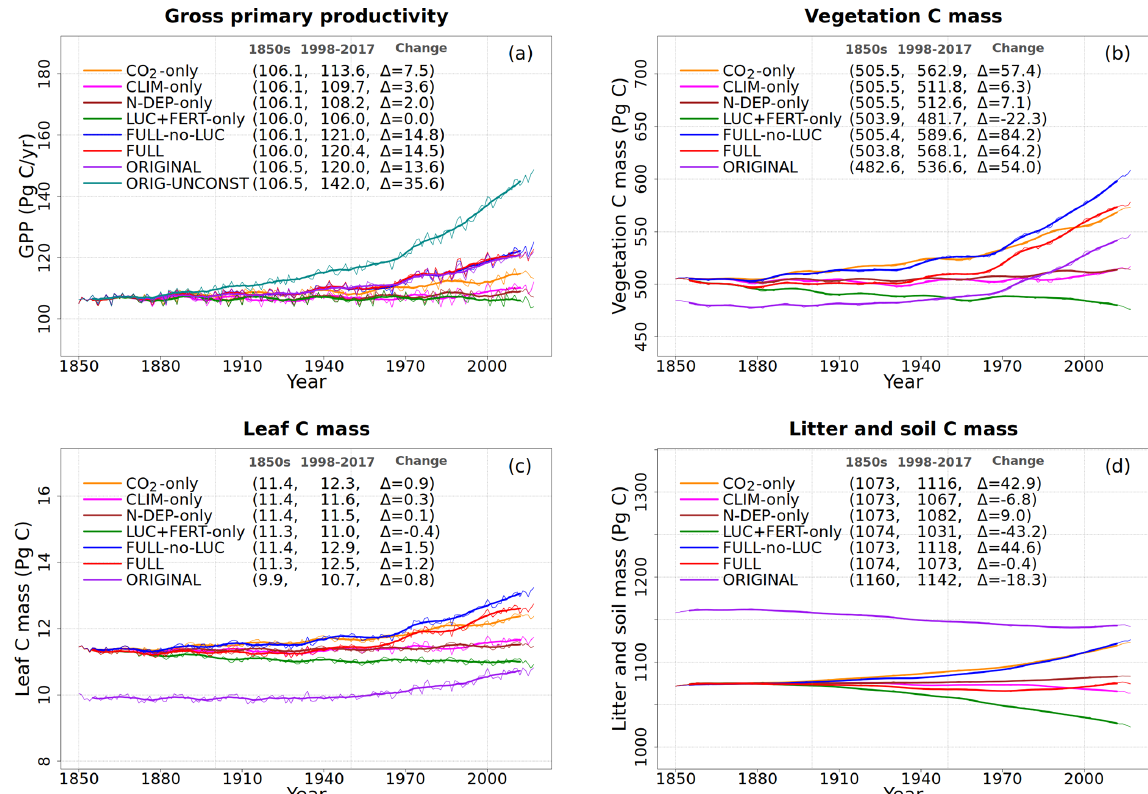
Figure 4. Global annual values of gross primary productivity (a) , vegetation carbon (b) , leaf carbon (c) , and litter and soil carbon (d) for the primary simulations performed. The values in the parentheses for legend entries show the average for the 1850s, the average for the 1998–2017 period, and the change between them. The thin lines show the annual values, and the thick lines show their 10-year moving